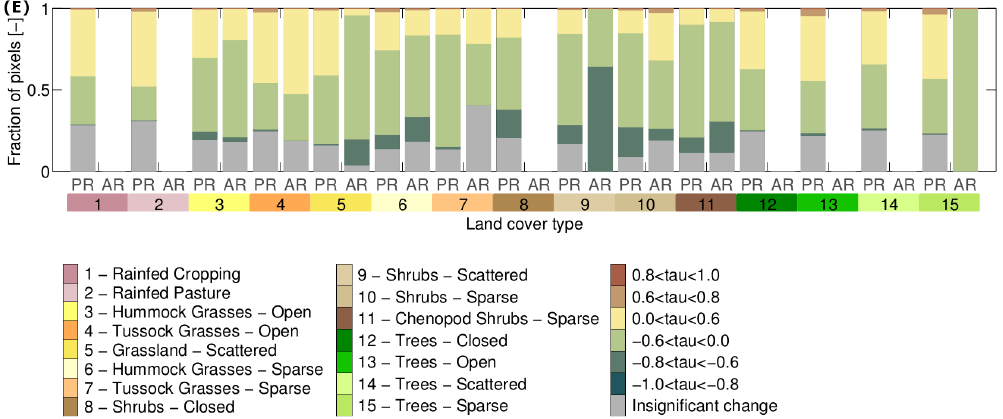
Figure 8. Overview of ( A ) the trend in Standardized Precipitation and Evapotranspiration Index (SPEI) over time and the non-parametric correlation coefficient Kendall’s tau for the stability metrics derived on the NDVI anomaly and climate time series: ( B ) to ( C ) a spatial overview and ( D ) to ( E ) overview per land cover type and disturbance regime (PR: productive lands; AR: arid lands/rangelands) for the ( B , D ) standard deviation (SD) and ( C , E ) auto-correlation at lag one (AC). Bar plots with a red-orange color indicate that changes in stability metrics on the SPEI are positively associated with changes in the NDVI anomaly (e.g., periods with low/high SD of the NDVI anomaly are associated with periods of low/high SD of the SPEI), while a blue-green color denotes negative association (e.g., periods with low/high SD of the NDVI anomaly are associated with periods of high/low SD of the SPEI). Red and blue colors suggest a strong association, while for yellow-green colors, the association is less strong. The pixels of which the stability metric derived over the whole time series length was not significant were not taken into account, and land cover types having 100 pixels or less were